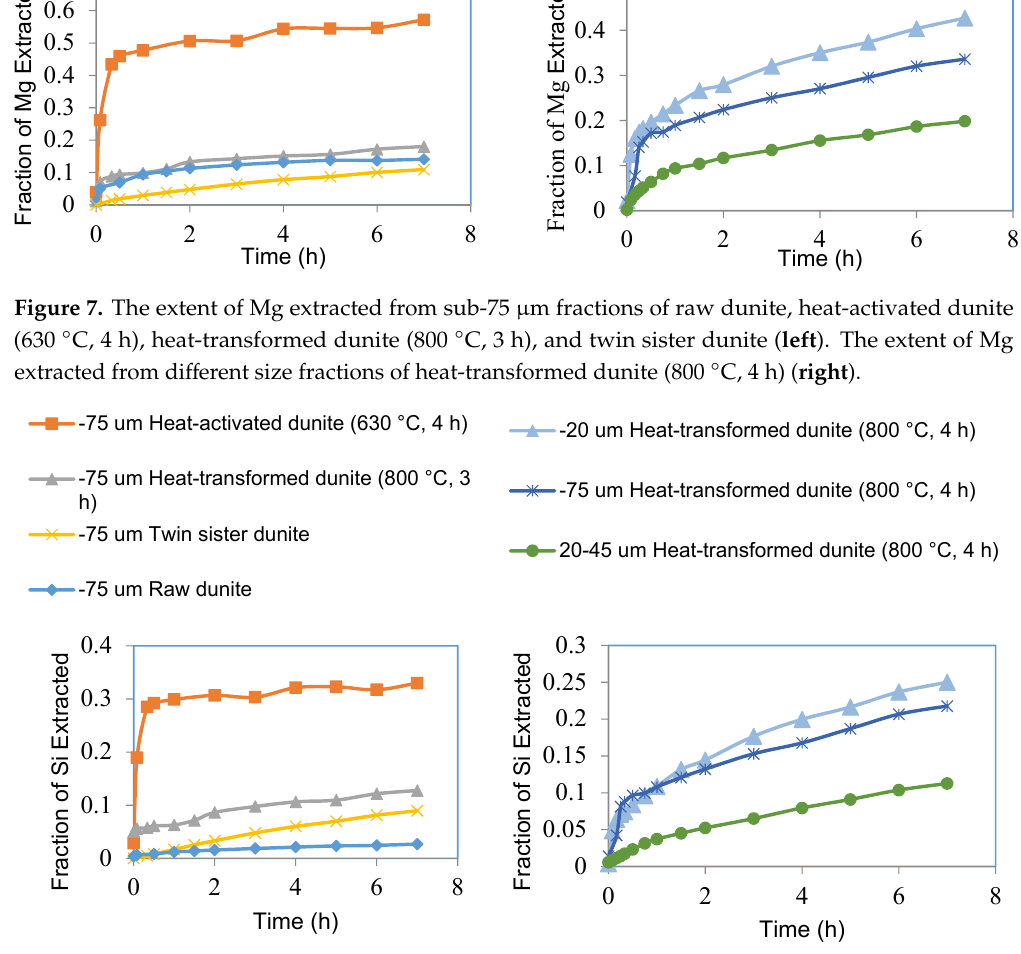
Figure 8. Fraction of silicon extracted from sub-75 µ m fractions of raw dunite, heat-activated dunite (630 ◦ C, 4 h), heat-transformed dunite (800 ◦ C, 3 h), and twin sister dunite ( left ). Fraction of magnesium extracted from sub-75 µ m fraction, sub-20 µ m fraction, and 20–45 µ m fraction of heat-transformed dunite (800 ◦ C, 4 h) ( right ).